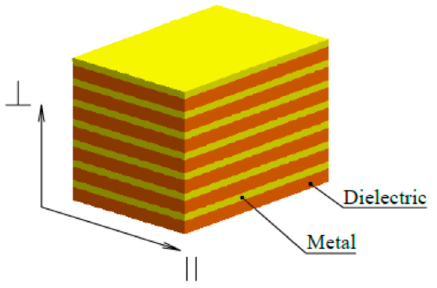
Figure 1. A view of a multilayered metamaterial (MM).